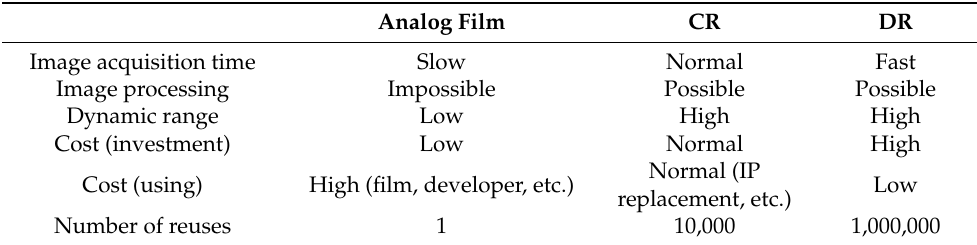
Table 1. The characteristic comparison table of the X-ray detection